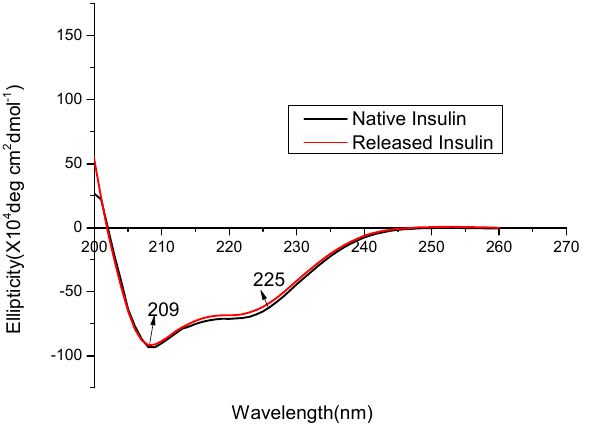
Figure 5. CD spectra of LD, insulin, LD-INS, F-40-INS, F-50-INS, and F-M-INS inclusion com- plexes.